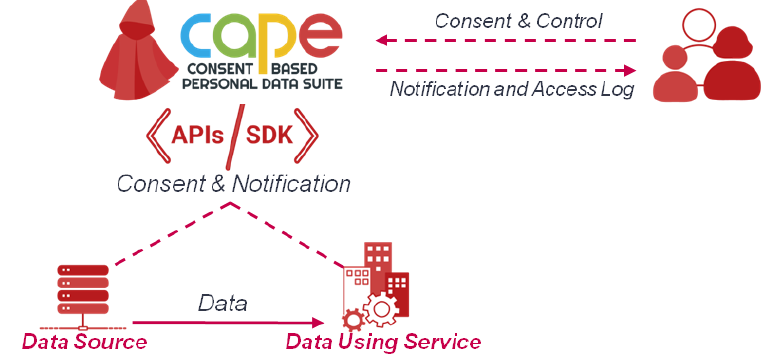
Figure 5. Overview of